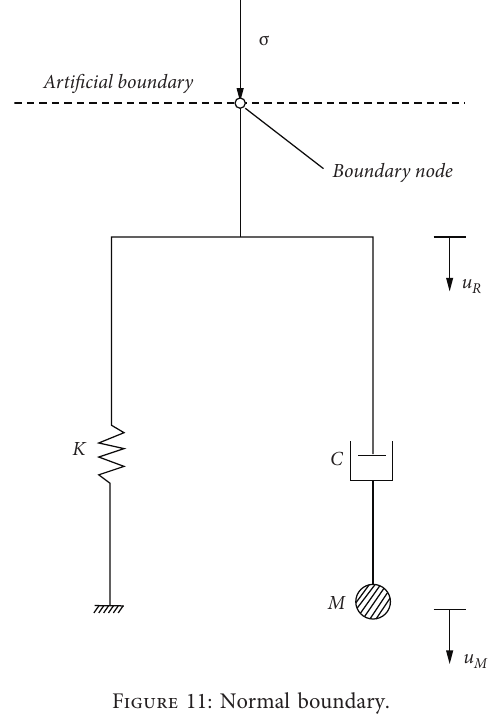
Figure 11: Normal boundary.